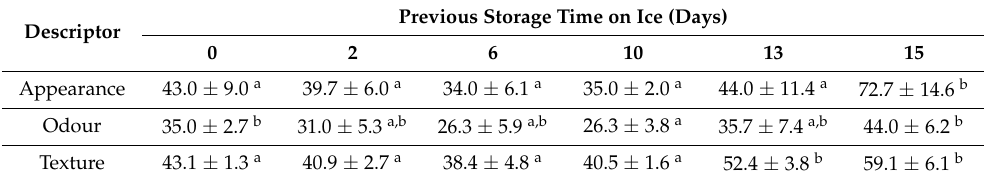
Table 3. Sensory acceptance of canned sardines subjected previously to storage on ice